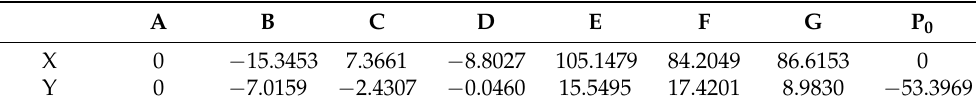
Table 1. Link pivot coordinate optimization